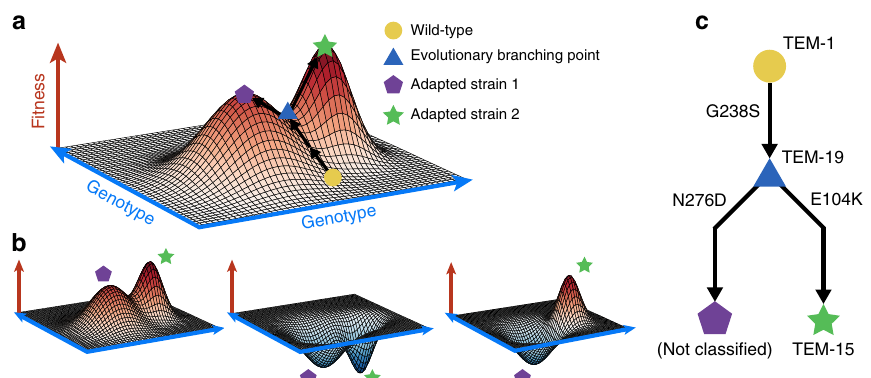
Fig. 1 Evolutionary saddle points can drive divergent collateral response. a A schematic fi tness landscape model in which divergent evolution can occur. Following Wright 26 , the x – y plane represents the genotypes and the height of the landscape above this plane represents fi tness. Two evolutionary trajectories, both starting from a wild-type genotype (yellow circle), are shown. These trajectories diverge at an evolutionary saddle point (blue triangle) and terminate at distinct local optima of fi tness (purple pentagon, green star). As the saddle point exists, evolutionary trajectories need not be repeatable. b Schematic landscapes for a potential follow-up drug are shown, the collateral response can be (from left to right): always cross-resistant, always collaterally sensitive, or dependent on the evolutionary trajectory that occurs stochastically under the fi rst drug. c A potential evolutionary branching point in the TEM gene of E. coli identi fi ed in the fi tness landscape for cefotaxime derived by Mira et al.